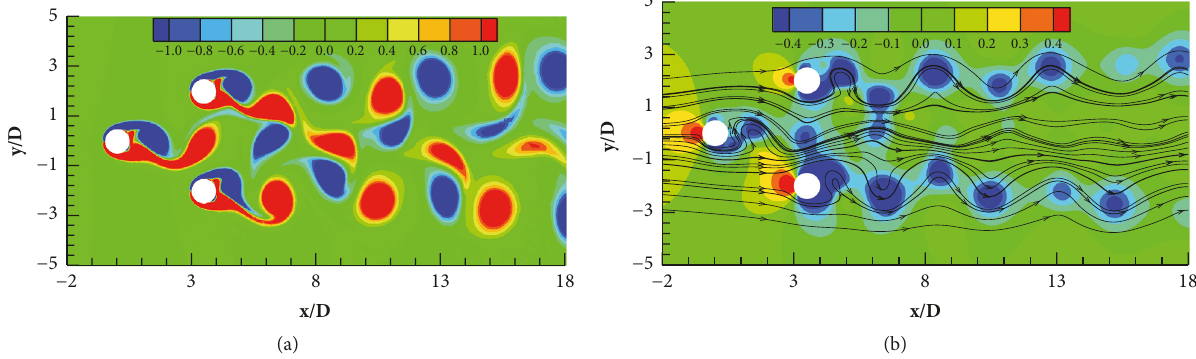
Figure 15: Snapshots of instantaneous flow fields at 𝑆/𝐷 = 4.0 with Re = 200: (a) vorticity contours and (b) pressure contours and streamlines.